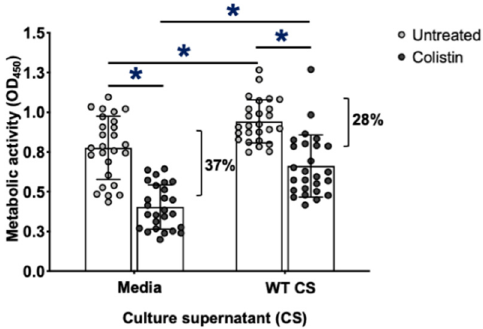
Figure 7. Adherent GAG-treated P. aeruginosa biofilms exhibit increased resistance to colistin. Biofilms of wild-type P. aeruginosa PA14 were growth in the presence of de- N -acetylated GAG-containing culture supernatants from wild-type A. fumigatus culture supernatants (WT CS) and then treated with 0.00117 mg/mL of colistin. Viability of P. aeruginosa was determined by XTT tetrazolium salt metabolism. Bars represent the means ± standard deviations of XTT supernatant measured at 450 nm of 5 independent experiments. A significant decrease in absorbance is indicated by * ( p < 0.0005) between untreated and treated groups and between treated groups and as determined by paired t test.